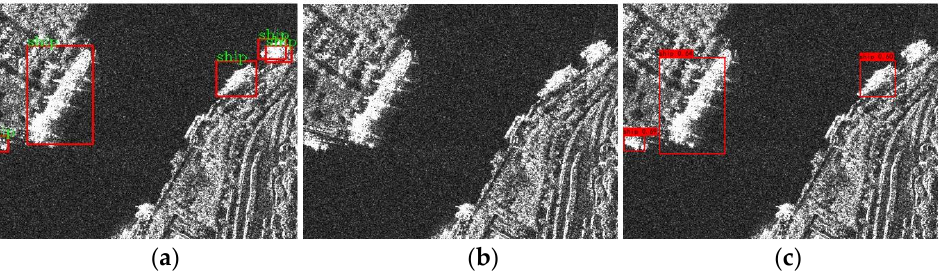
Figure 16. Ship detection is affected by the coastal environment in SAR images. ( a ) Correct position of the ship in the SAR image; ( b ) Ship detection effect of YOLO V5 in SAR images; ( c ) Ship detection effect of FLNet in SAR images.